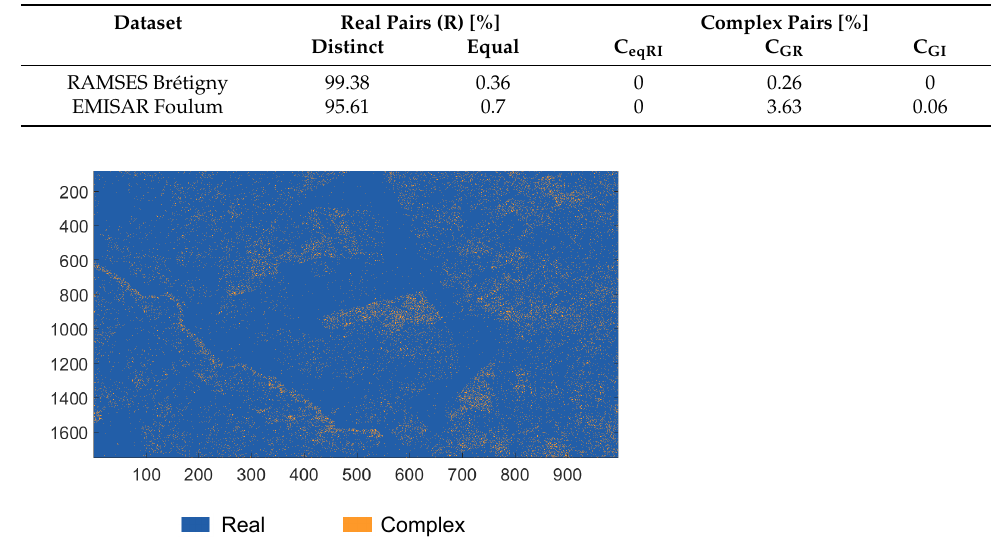
Table 5. Classification of RR eigenvalues for two real datasets.